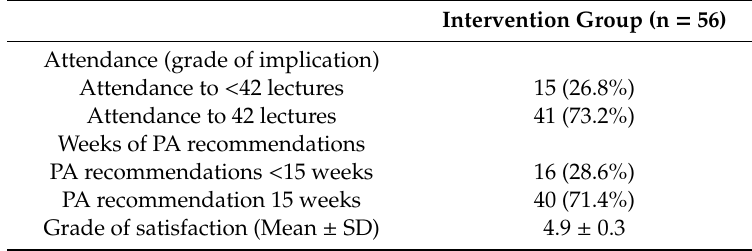
Table 3. Frequency of attendance to gamification-based lectures of the program, frequency of weeks meeting PA recommendation, and grade of satisfaction with respect to the “Matrix rEFvolution” program of college students from intervention group.